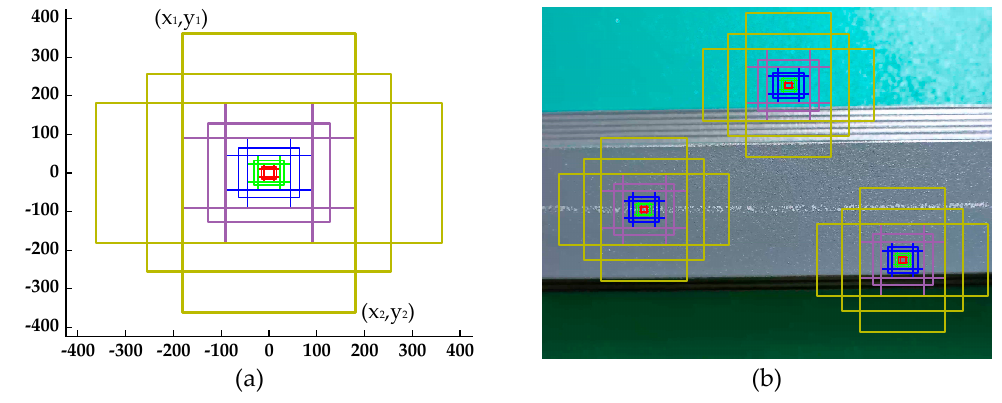
Figure 8. ( a ) Fifteen kinds of anchors; ( b ) anchors set on the input image.